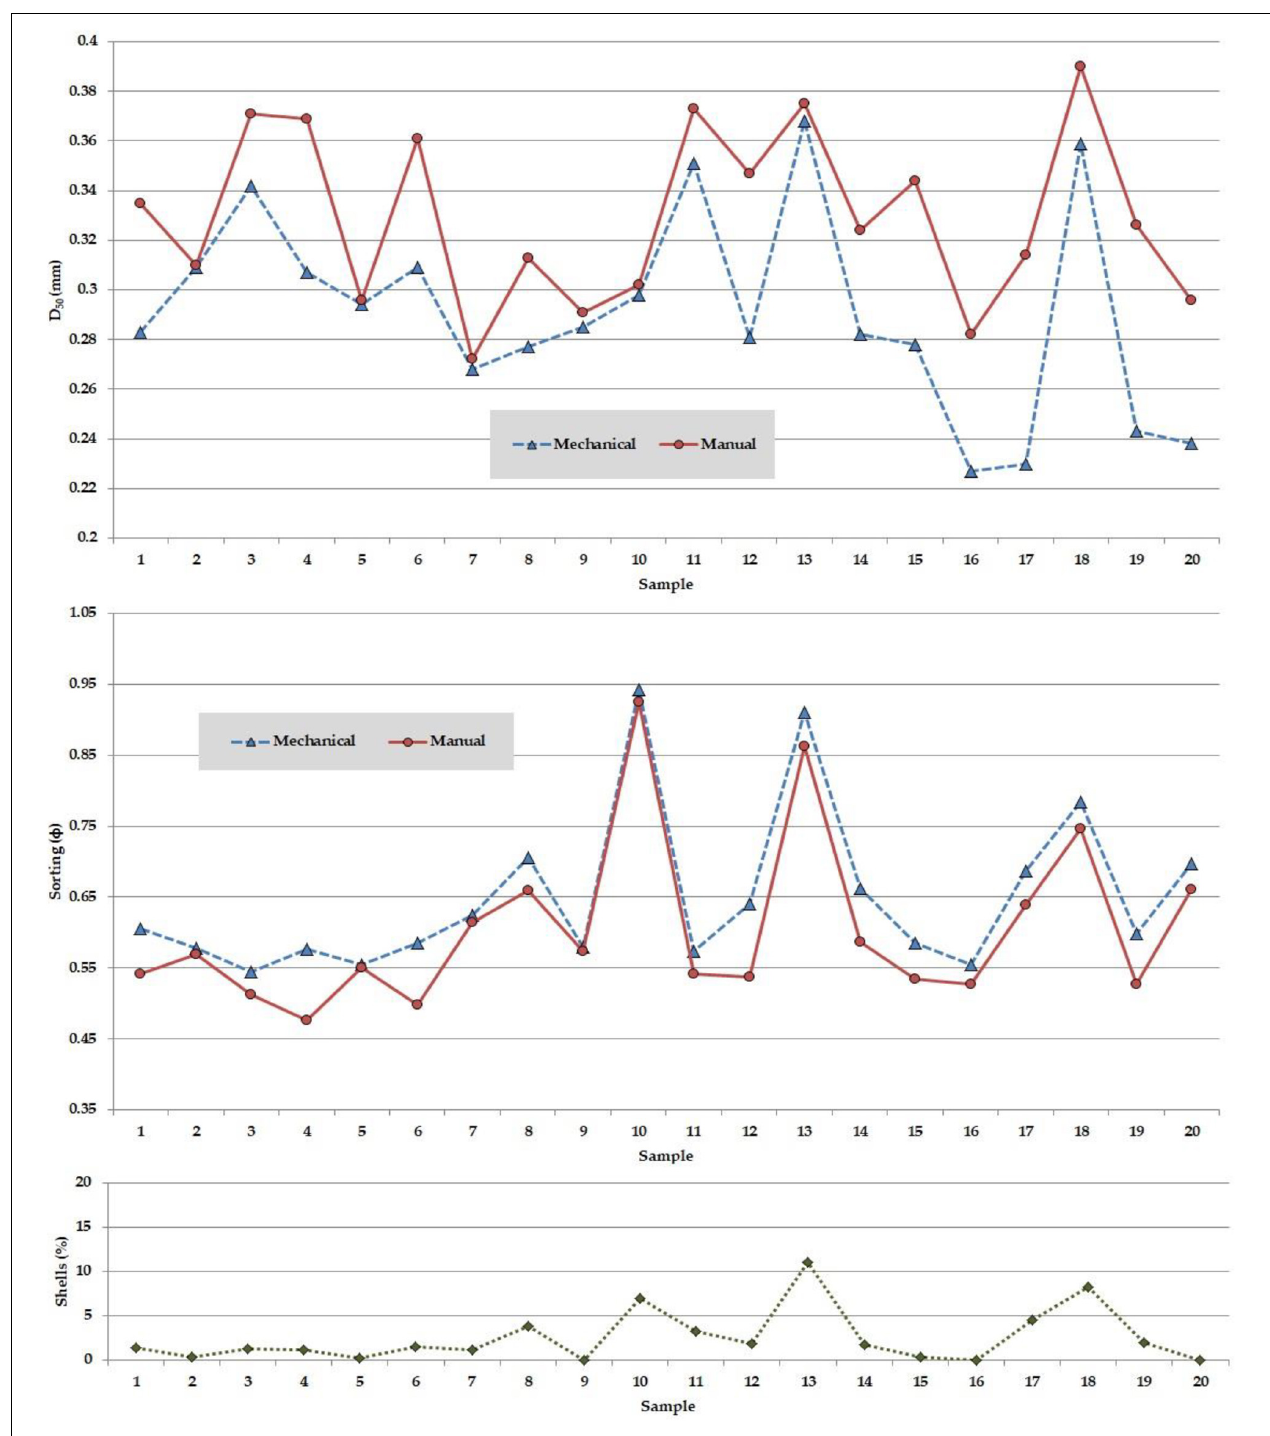
FIGURE 3 | Graphical results of the granulometric parameters of 20 sand samples, D 50 (mm) and sorting ( ϕ ) for mechanical and manual sieving methods with 10 cm diameter sieves. Percentage of shells is also shown.